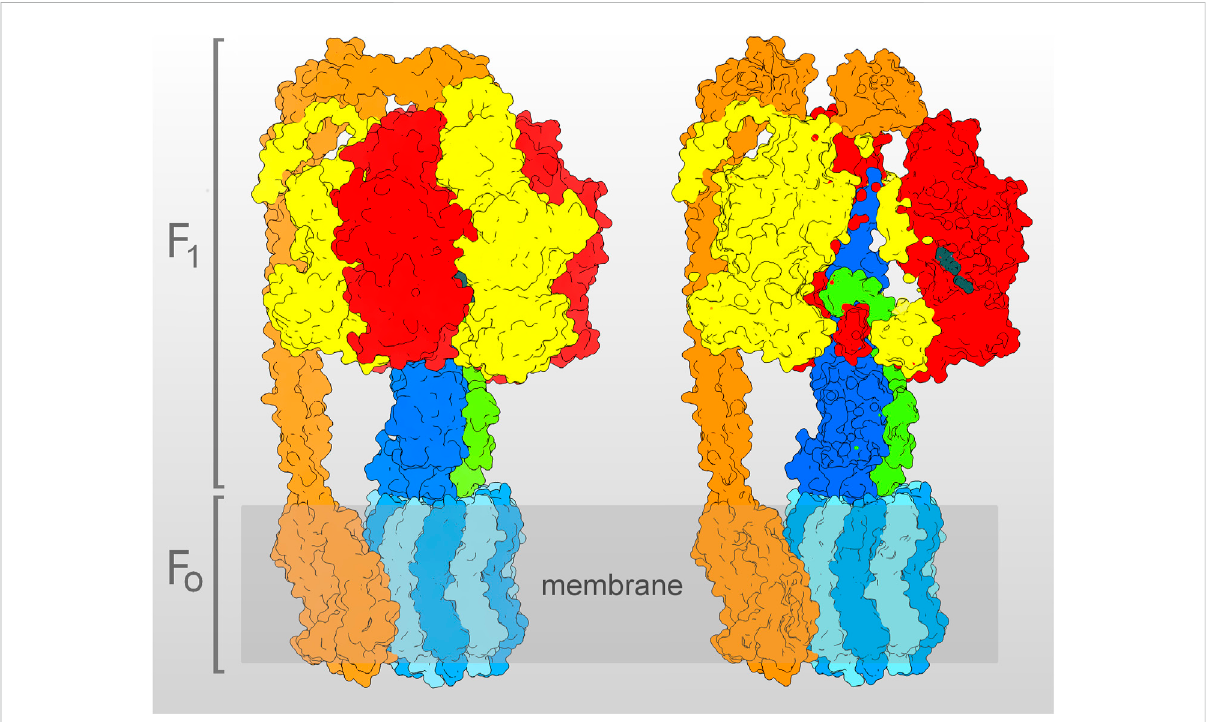
FIGURE 1 Molecular model of the E. coli ATP synthase, determined by cryo-EM (Sobti et al., 2020, PDB entry 6oqr, with the complex in the ε -subunit “ up ” state – see Section 3). On the left, the whole model is shown, on the right, the same model is clipped, to show the γ - (blue) and ε - (green) subunits β α -subunitinyellow, β -subunitinred).Thec γ -and ε -subunits,build fi llingtheinnercavityofthe α 3 3 -barrel( 10 -oligomer(lightblue),togetherwiththe the rotor, while the stator is constituted by the α 3 β 3 -barrel and by the peripheral stalk (orange), composed by the δ -, b 2 -, and a-subunits. In the clipped model,theADP and Pi bound to thecatalytic site ofthe β 1 are visible (dark gray). The model was represented using USCF Chimera (Pettersen et al.,